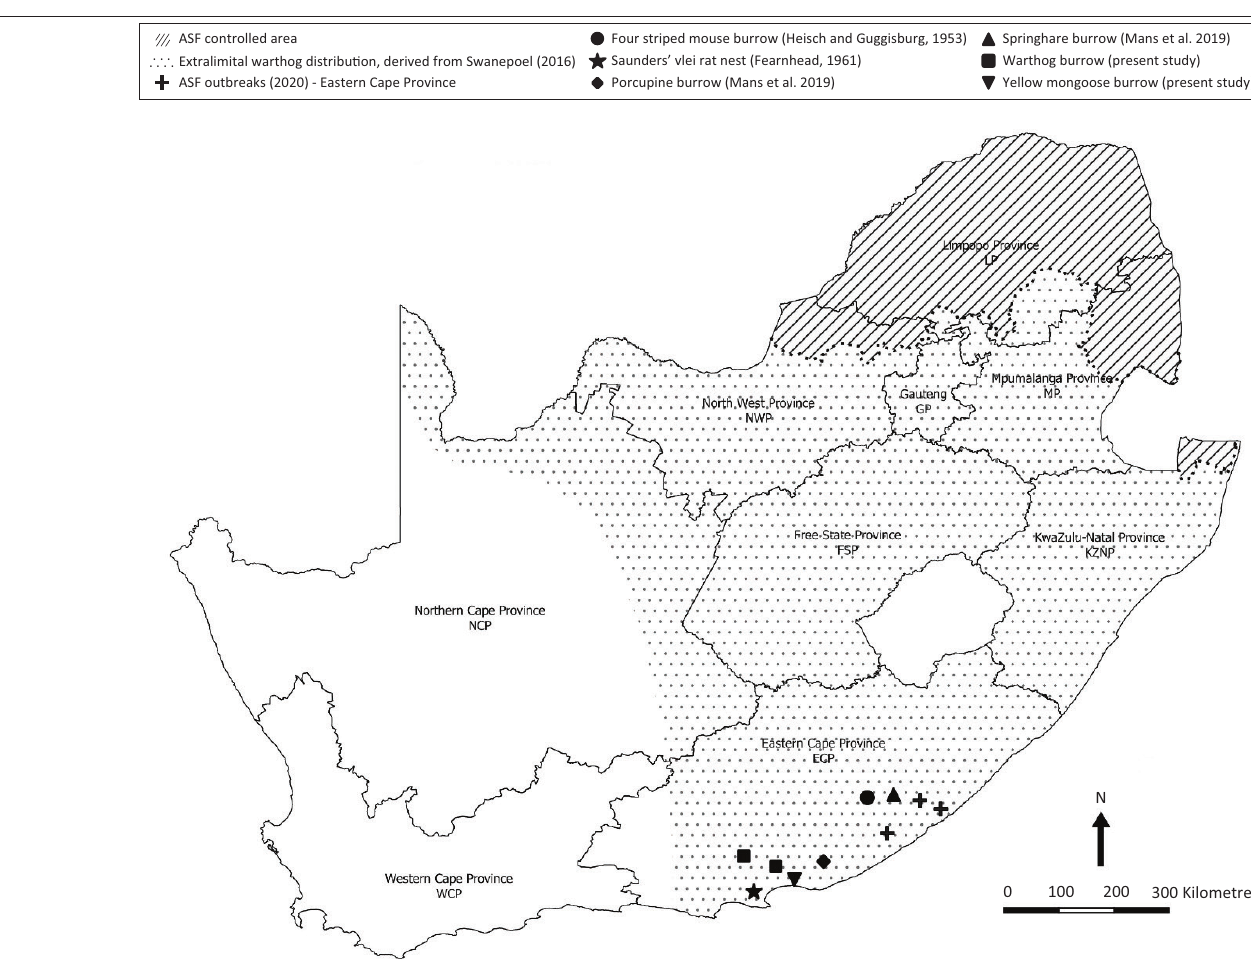
FIGURE 1 : Map showing the African swine fever (ASF) controlled area in South Africa, the distribution of extralimital warthogs derived from Swanepoel (2016), the sites of ASF outbreaks in domestic pigs in the Eastern Cape Province in 2020 and the sites of collection of Ornithodoros (Pavloskyella) zumpti ticks from host-associated sites as